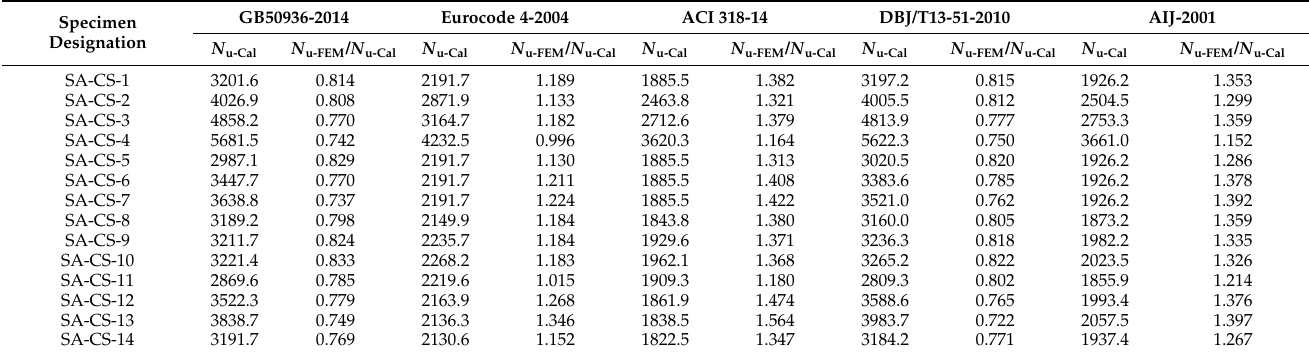
Table 4. Comparison of ultimate bearing capacity between FE results and design